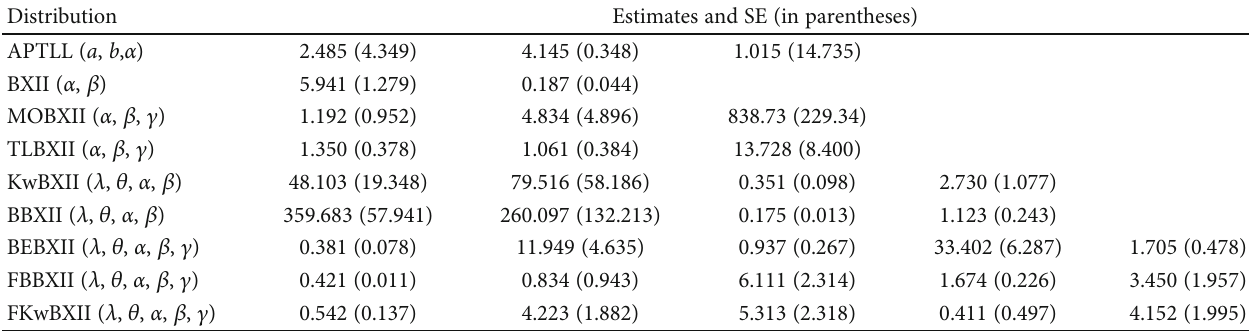
Table 5: Estimates and SE (in parentheses) for breaking stress data.